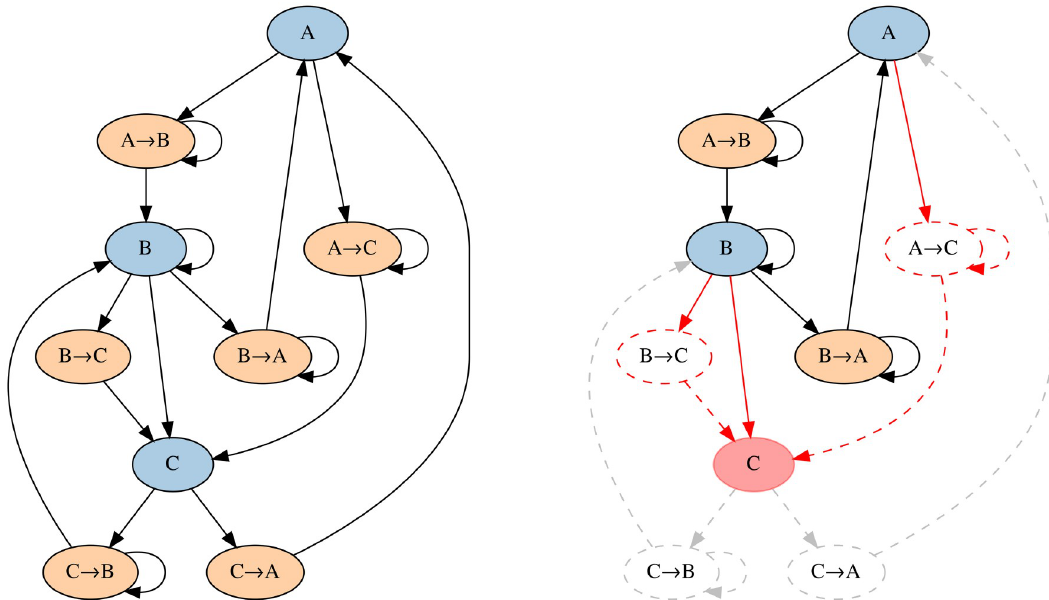
Fig 1. StationRank architecture. Example sub-network incorporating temporal and modal aspects. The nodes are Markovian states. We distinguish between dwell states which are actual stations, such as ( A ), and running states which are transits between stations, such as ( A ! B ). Stations like ( B ) and ( C ) might be both directly and indirectly linked due to differences in speed of connecting trains. A disruption at node ( C ) can be caused by means of reducing all of its